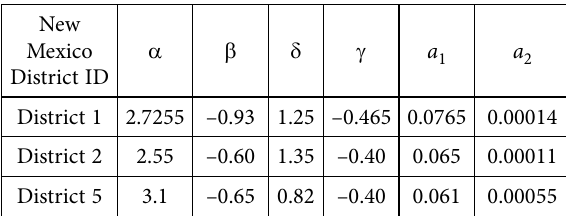
Table 5. Summary of mastercurve parameters for HMA mixes collected